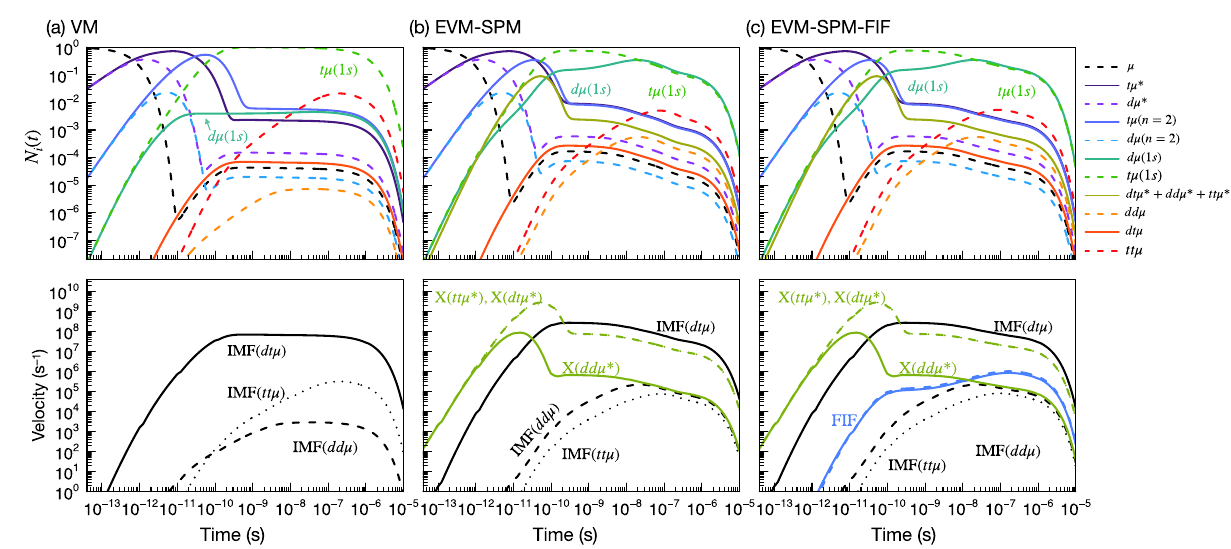
Figure 4. Upper panels: Time evolution of population of muonic atoms/molecules for ( a ) VM, ( b ) EVM-SPM, and ( c ) EVM-SPM-FIF kinetics models at c t = 0.5 , ϕ = 0.5 , and T = 800 K. Lower panels: Velocities of nuclear fusion and X-ray emission